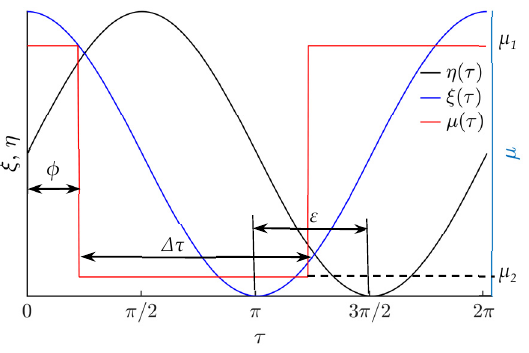
Figure 2. Principle of dry friction control in respect of the period of the function defining the circular motion of the platform.